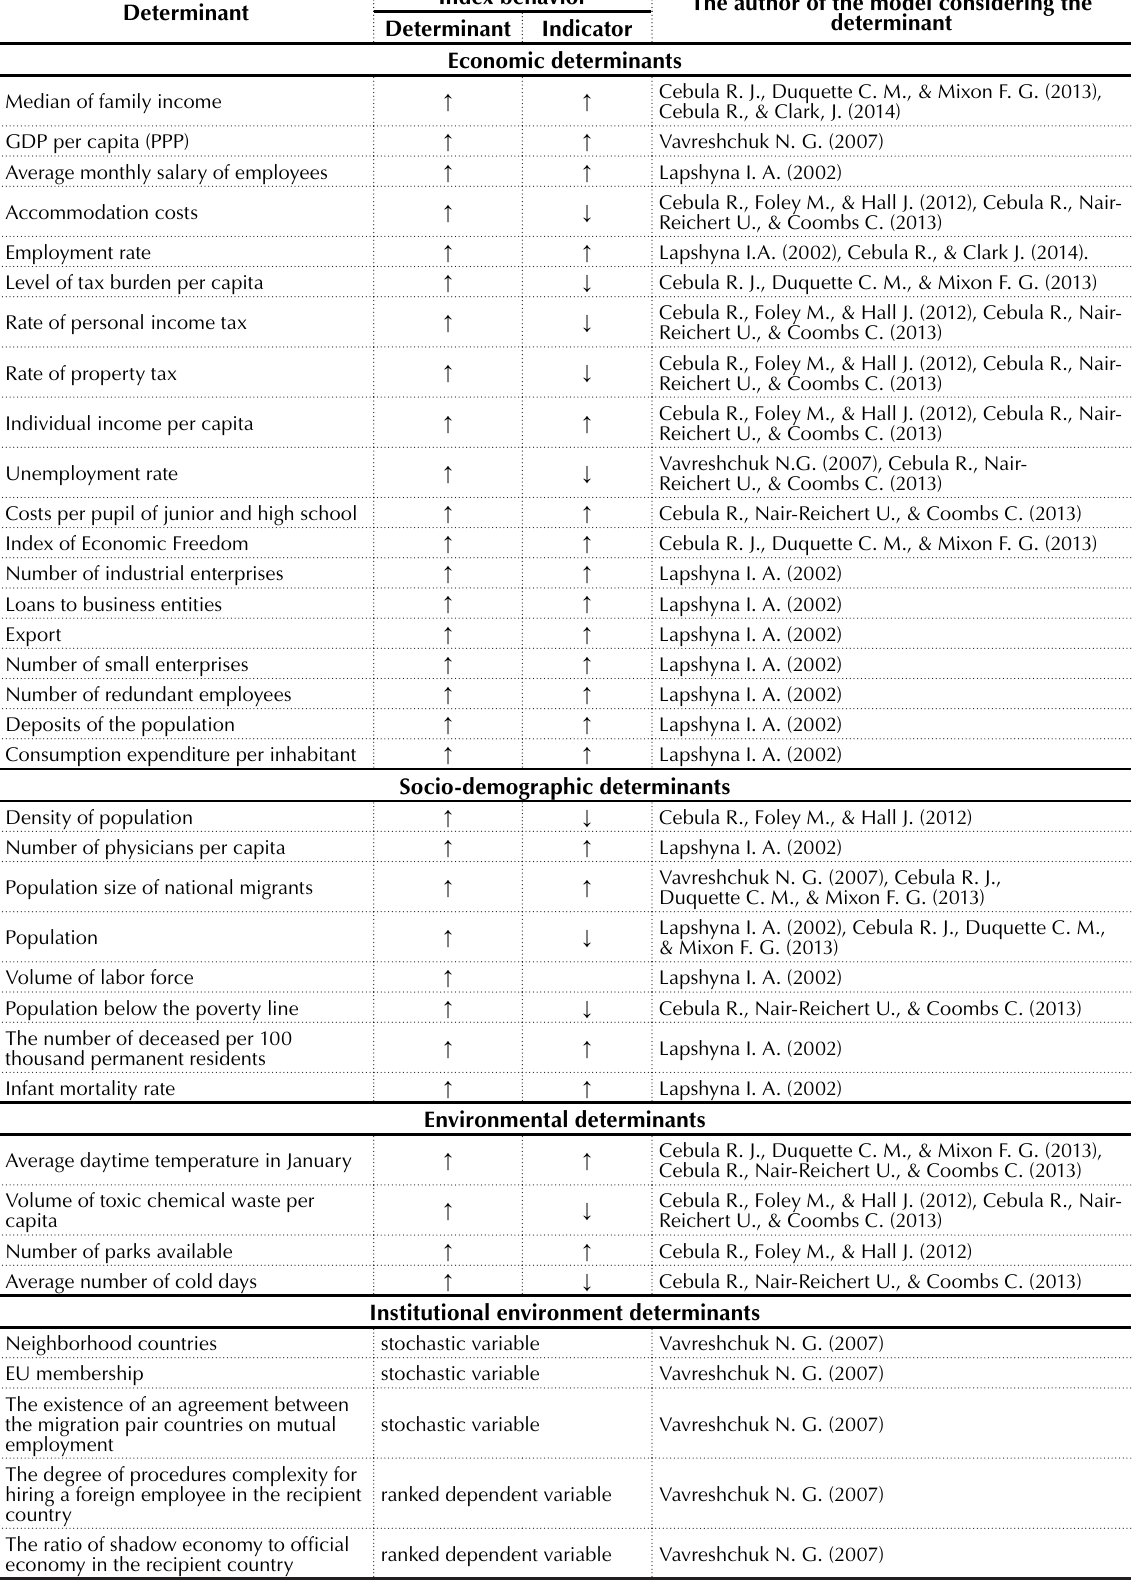
Table 2. The analysis of individual determinants of migration motives formation Index behavior The author of the model considering the Determinant determinantDeterminant